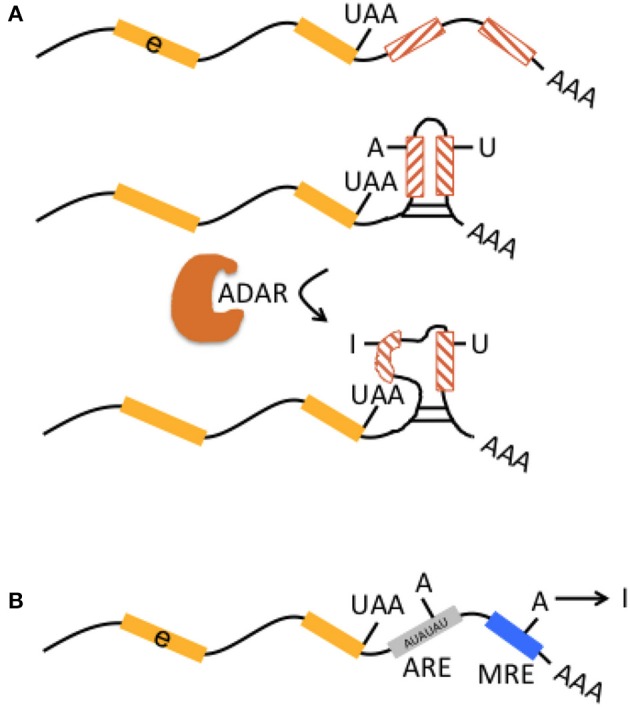
Interaction of RNA editing and retrotransposons at the pre-mRNA level. (A) Multiple non-LTR retrotransposons may be present in 3′UTR [indicated by preceding exon (e, yellow boxes) with stop codon “UAA”] in inverted orientation (lines in hatched boxes point in opposite directions). They may form perfectly matched double-stranded RNA structures (middle graph). Inverted-retrotransposon double-stranded RNA structures may also undergo A-to-I editing by ADAR, resulting in loop formation within double-stranded RNA (lower graph). The formation of partially matched double-stranded RNA structures in the 3′UTR is implicated in escape from cytosolic immune response. (B) AU-rich elements (ARE, gray box) and microRNA response elements (MRE, blue box) in 3′UTRs represent binding sites for proteins and microRNAs that can affect mRNA stability and translational efficiency. A-to-I editing may modulate adenosines within ARE and MRE and thus indirectly influence those mechanisms.